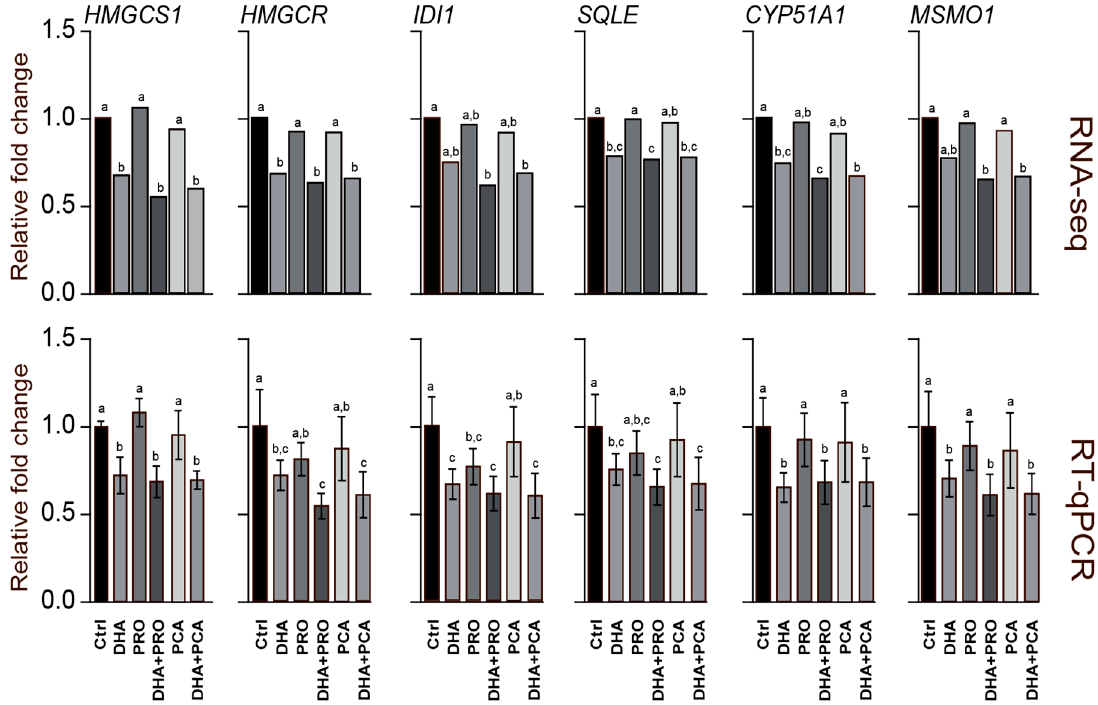
Figure 3. Comparison of transcriptional effects of 24 h exposure to DHA, PRO and PCA on genes involved in steroid biosynthesis (3-hydroxy-3-methylglutaryl-CoA synthase 1, HMGCS1 ; 3-hydroxy-3-methylglutaryl-CoA reductase, HMGCR ; isopentenyl-diphosphate Δ isomerase 1, IDI1 ; squalene epoxidase, SQLE ; cytochrome P450 family 51 subfamily A polypeptide 1, CYP51A1 ; methylsterol monooxygenase 1, MSMO1 ) mapped by RNA-seq and RT-qPCR. Data are represented as the mean fold change of relative expression compared to control cells. Statistical analysis was carried out using one-way ANOVA followed by Tukey’s HSD test. Different letters indicate statistical significance ( p < 0.05).